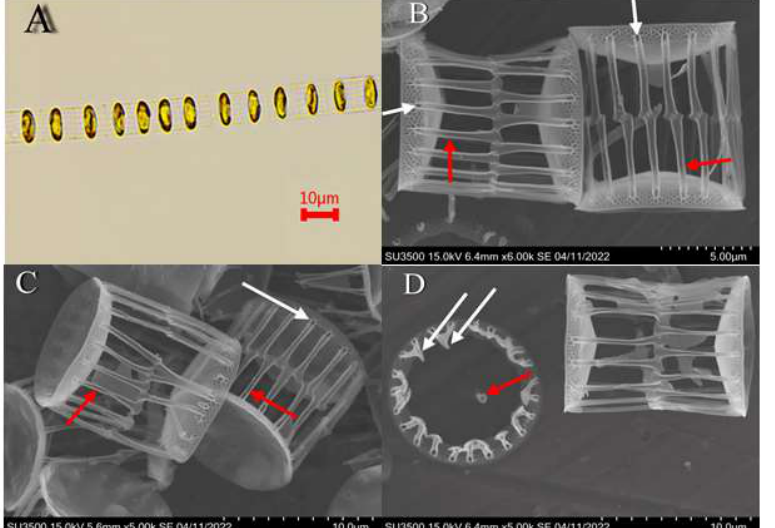
Figure 4. Skeletonema costatum : ( A )—light microscopy, fragment of chain; ( B – D )—SEM: ( B , C )—valves of two cells connected by fultoportula processes: intercalary fultoportula processes (red arrow), external pore (white arrow); ( D )—rimoportula (red arrow), claw-like protrusion (white arrow).